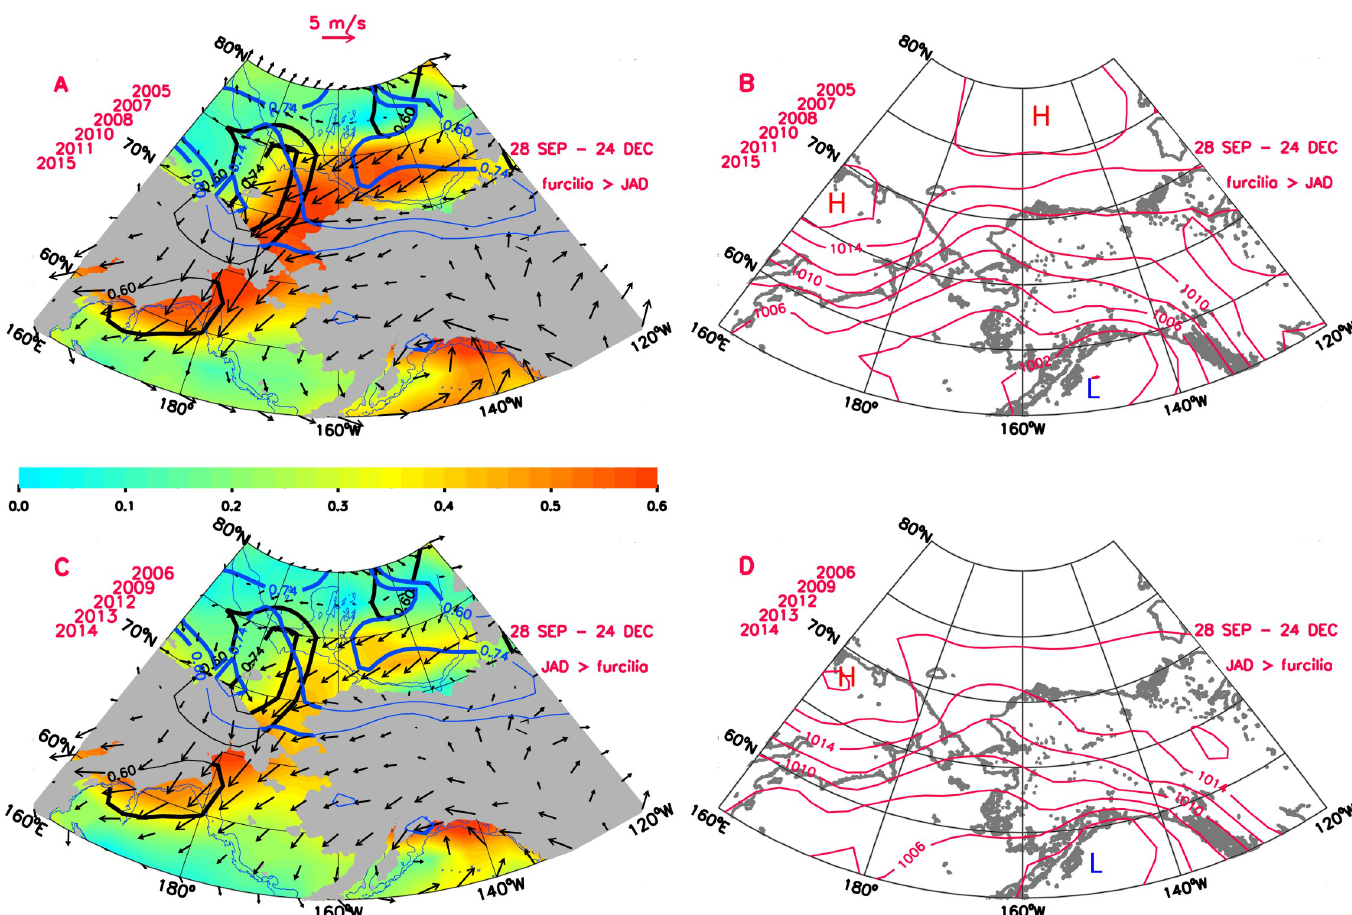
Fig 7. Mean atmospheric circulation from 28 September to 24 December for years preceding years in which furcilia fractions are greater (A, B) or lesser (C, D) than JAD fractions. Year annotations indicate krill survey years. A) and C) display mean wind vectors (at every 2nd i th grid point), wind directional constancy (color shading) and statistically-significant correlations between JAD fraction and U-component winds (blue contours) and V-component winds (black contours) with correlation contours at r = 0.60 (p < 0.05) and 0.74 (p < 0.01). B) and D) display mean sea level pressure (hPa) patterns. High and low pressure cells are annotated with H and L, respectively. Maps generated using IDL (Interactive Data